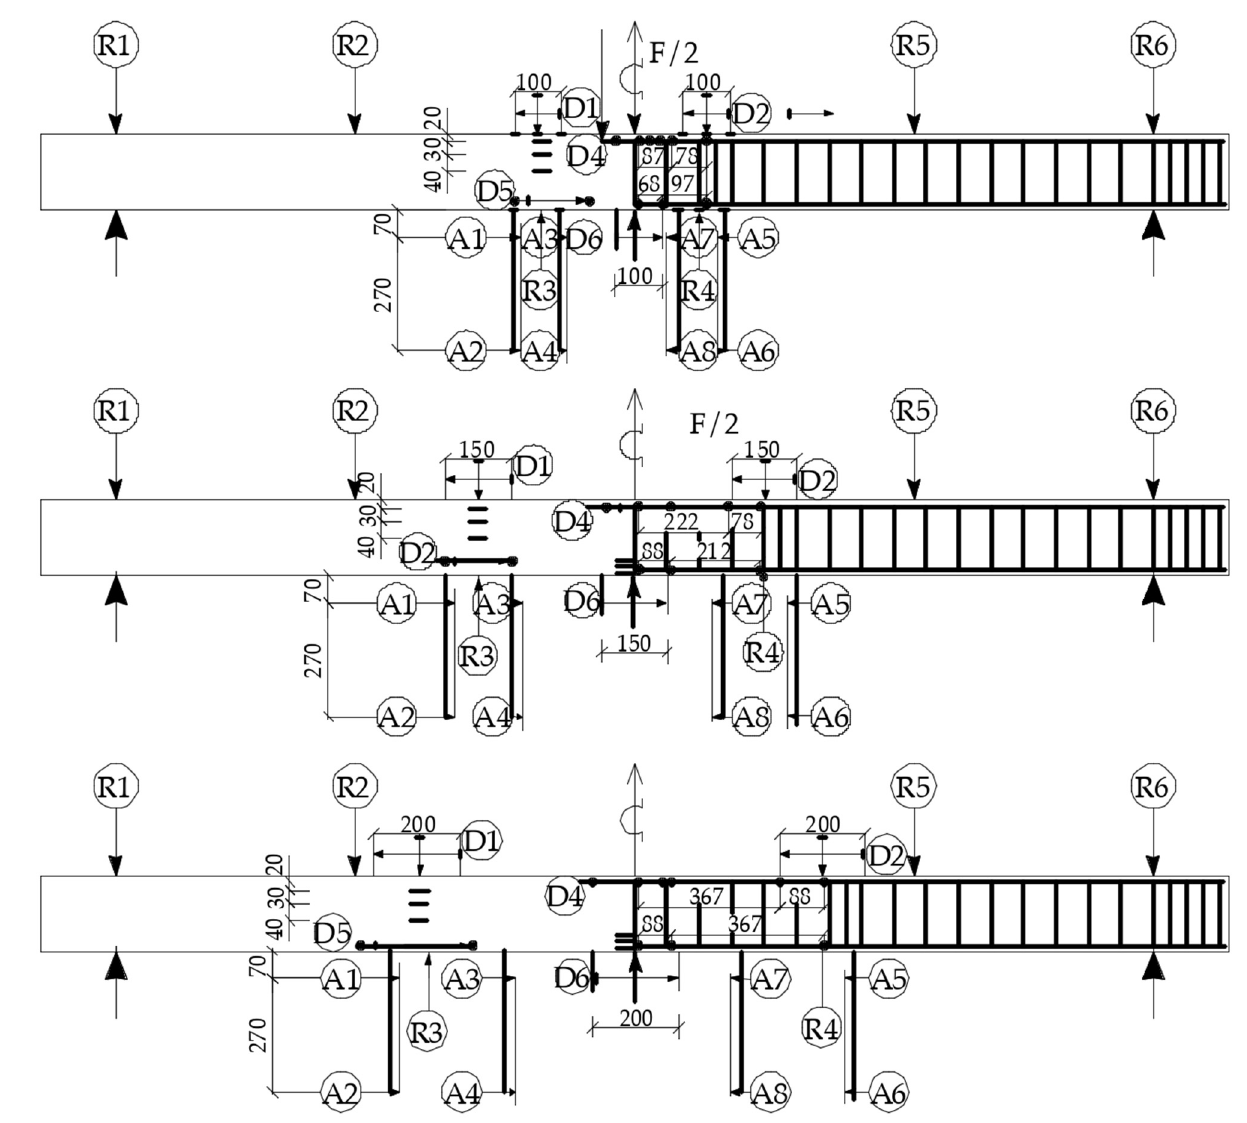
Figure 3. Scheme of loading, placement of devices and stickers of strain gauges in experimental two- span beams with small, medium, and large spans of the cut, where Ri—run-meter, Di—clock-type indicator for measuring concrete deformations in a compressed zone, as at the level of the center of gravity of a tensile reinforcement, Ai—clock-type indicator for the angles of rotation of normal sections of a continuous beam.